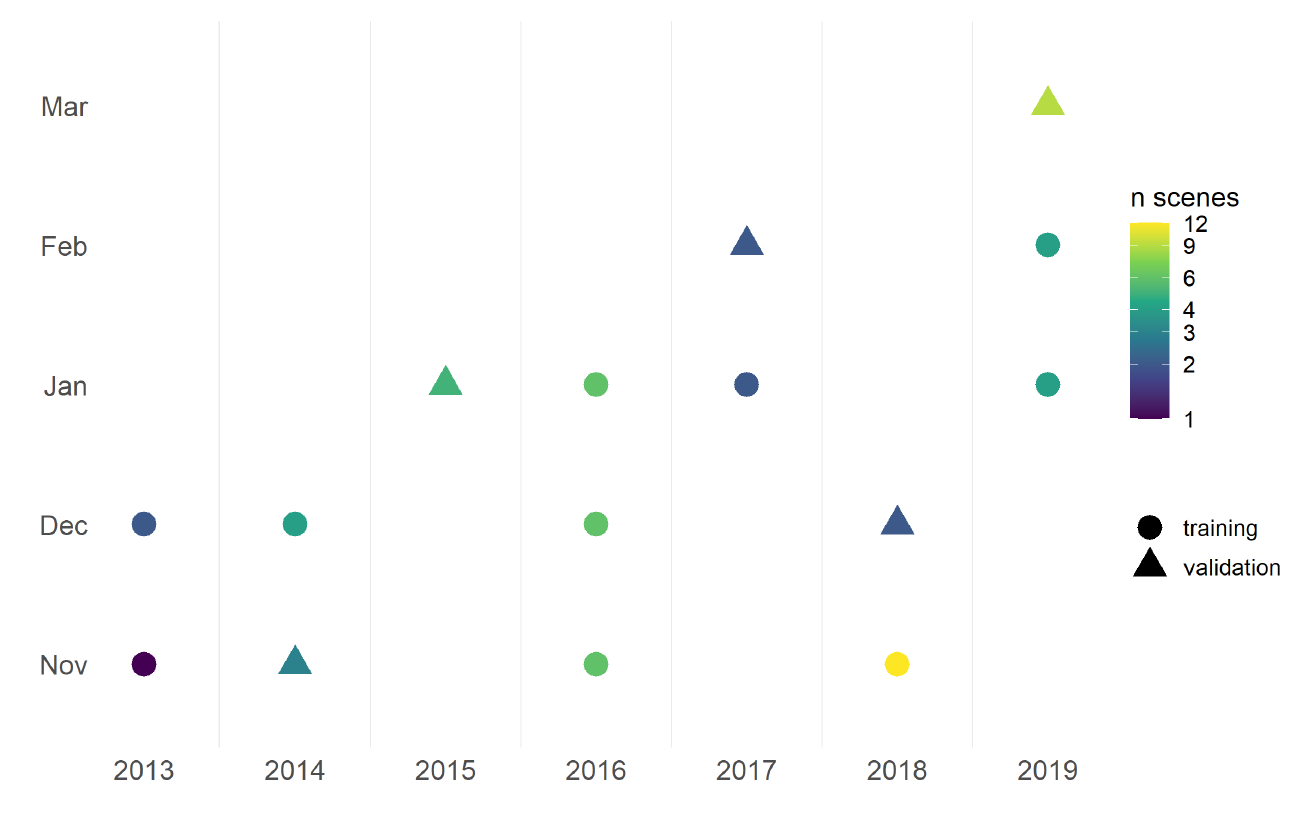
Figure 2. Amount of closely matching MODIS and Landsat 8 scenes by month as well as months selected for training vs. temporal external validation. Training months n = 10, validation months n =